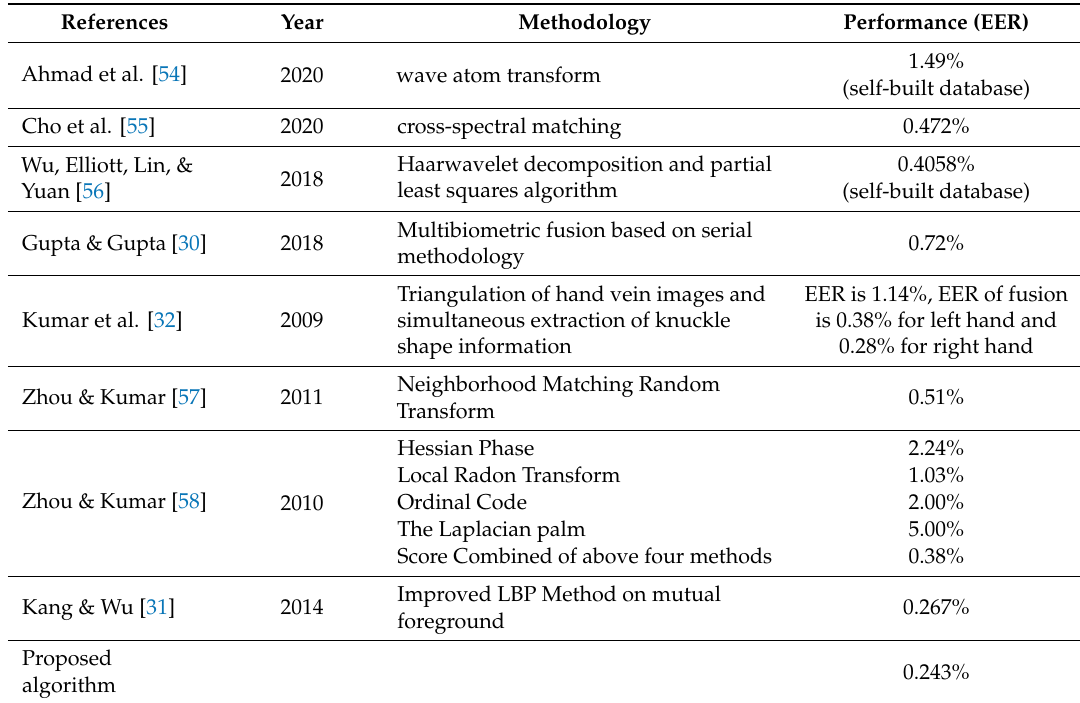
Figure 30. Detection-error tradeoff (DET) curve plotted between FMR against FNMR. Table 2. Performance comparison of our algorithm with other matching algorithms at EER.